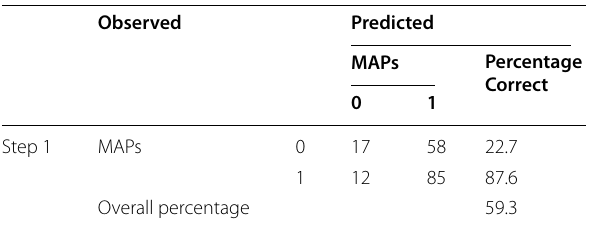
Table S: Classification table for stability culture